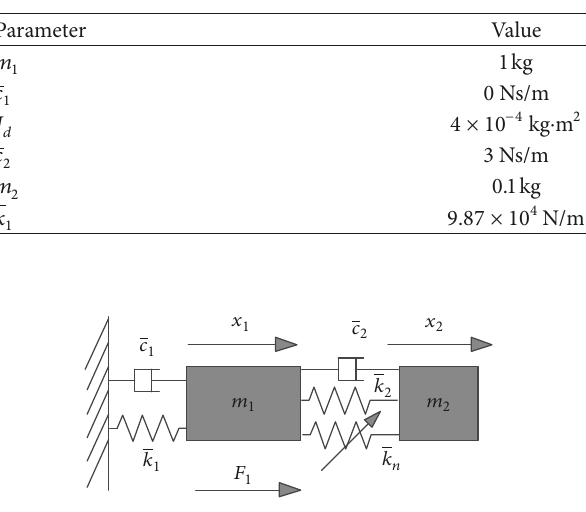
Figure5:Dynamicmodeloftherotor-NESsystemwhengyroscopic effect is ignored.